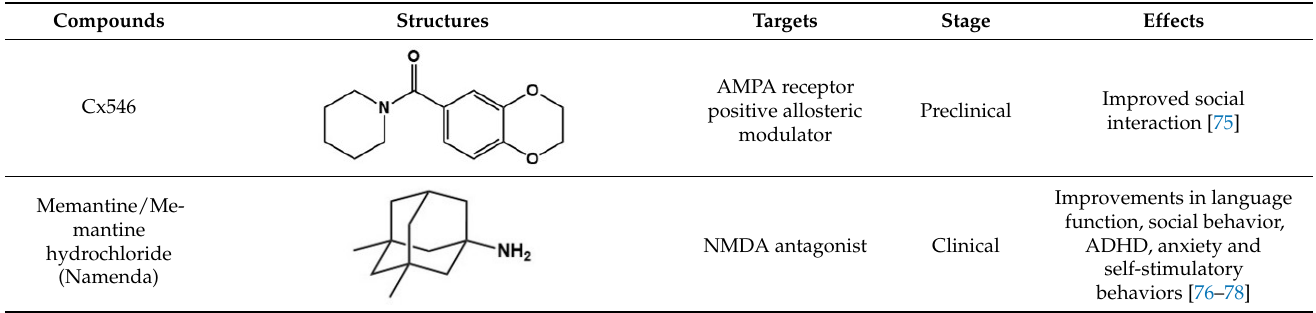
Table 2. Glutamate-related pharmacological agents and their potential effects on treating ASD